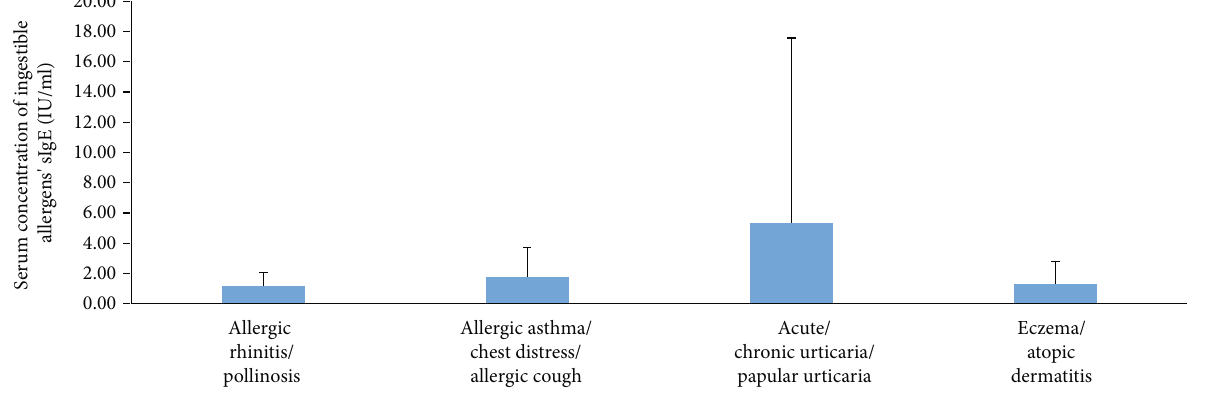
Figure 4: Mean value of ingestible allergen ’ s sIgE in di ff erent diseases.